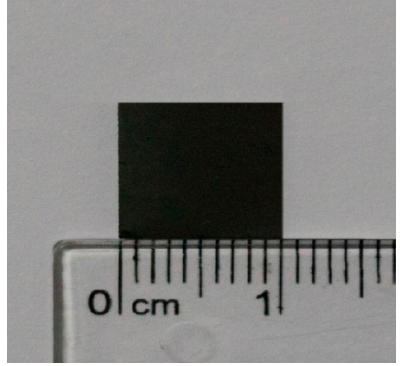
Table 1. Growth parameters for the carbon nanotubes (CNTs) on stainless steel surfaces.